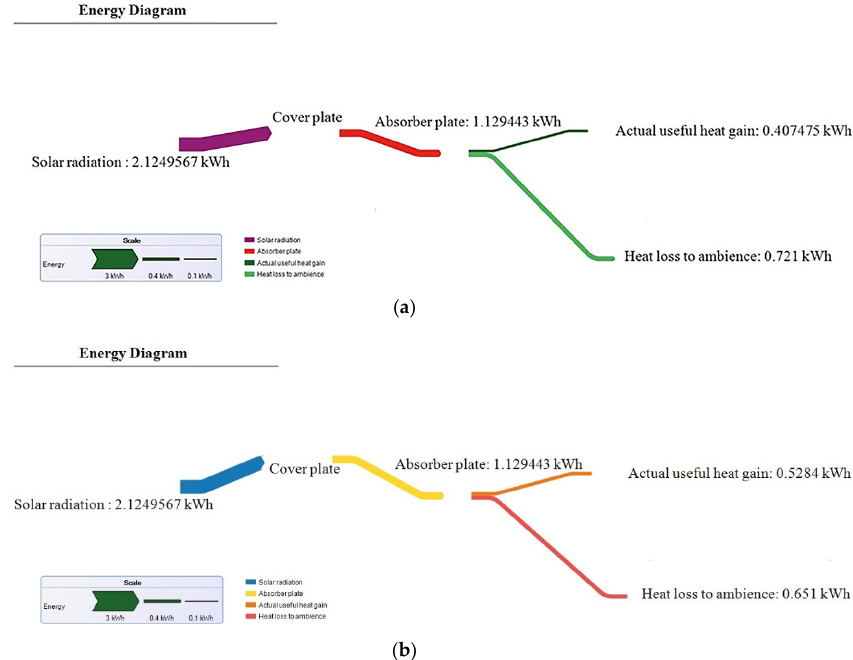
Figure 9. Energy diagrams for two different systems (( a ) a system with natural draught; ( b ): a system with a conventional dryer).